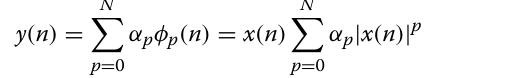
Table 4 Estimated efficiency bounds (%) OFDM 5